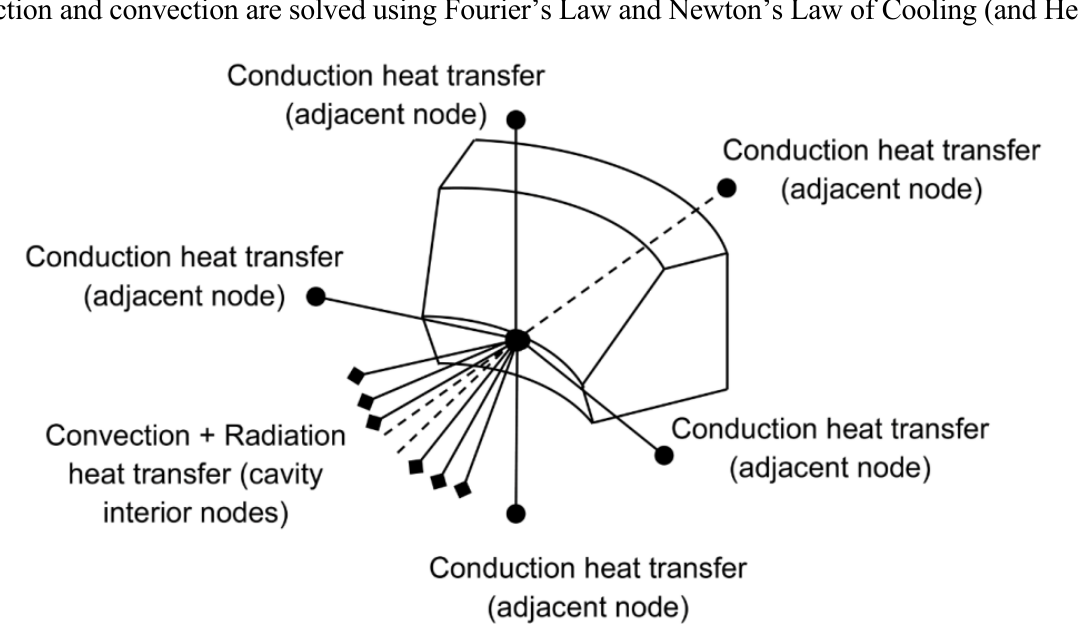
Figure 5. Heat contribution. Cavity border